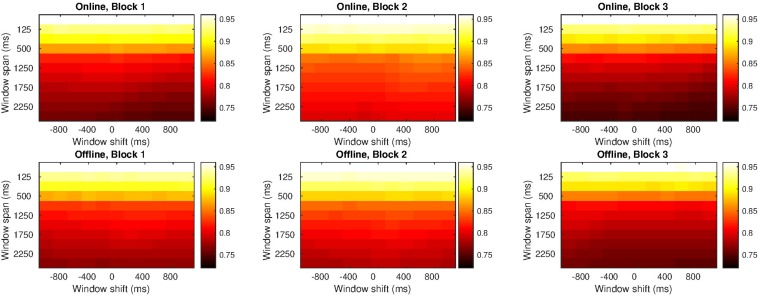
Correlation indices for different windows span and delay times in Study 2. Each row refers to a type of agent (human online and human offline) and each column refers to either block 1, block 2, or block 3. Inside each graph, the horizontal axis is the delay applied (from –1 s to 1 s), with the central column showing no delay at all. Vertical axis alludes to the window span and it ranges from 50 ms (at the top) to 2500 ms (at the bottom). Light colors indicate higher correlation and dark colors indicate lower correlation. All the graphs show the same scale of colors; then, colors can be compared among graphs.